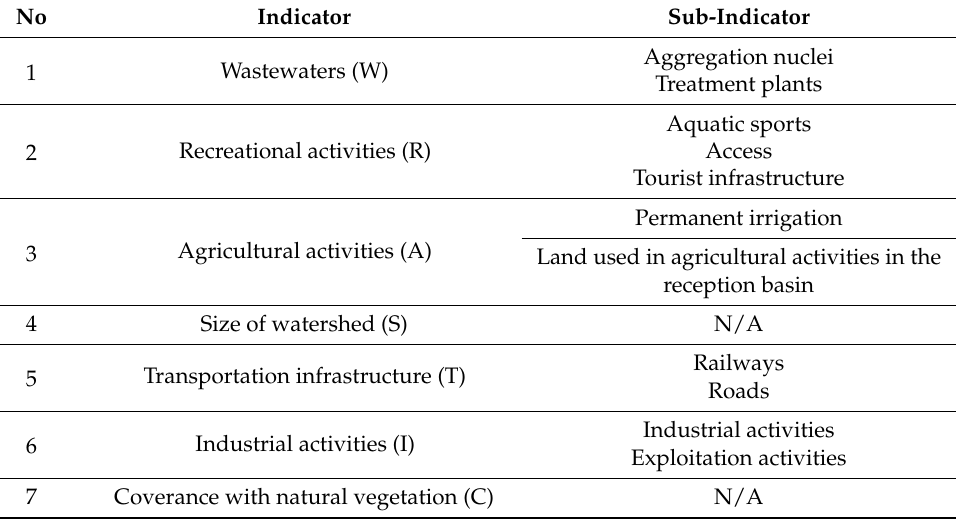
Table 3. Indicators used in the calculation of Hazard Index (HI). Table 2. Indicators used in the calculation of the WRASTIC (Wastewater–Recreation–Agriculture–